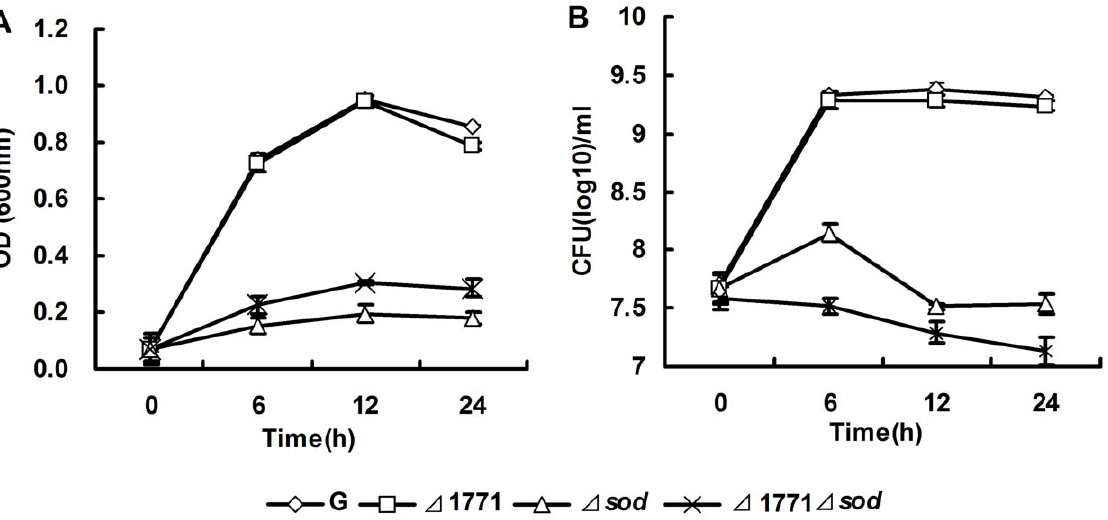
Figure 5. MV tolerance in planktonic cells of different L.monocytogenes strains. The wild-type L. monocytogenes 4b G (G), D 1771, D sod and D 1771 sod were grown in TSB + 1 mM MV broth respectively, measured the absorbance at OD 600 (A) and plated on TSB agar plates (B). The experiments were repeated three times and error bars indicate the standard errors of the mean.